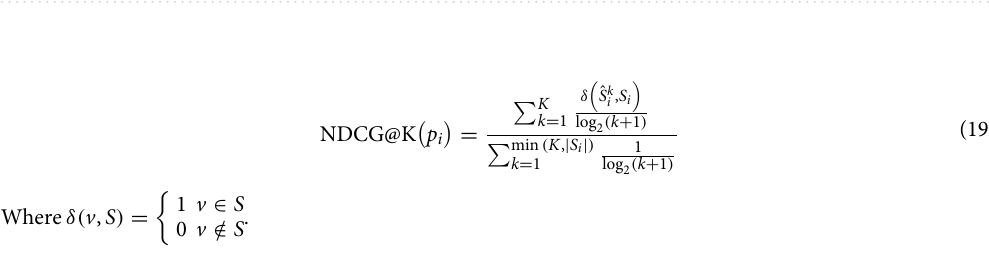
Table 2. The performance of each model. The best results in the comparison methods are in bold, and the results of our method are in